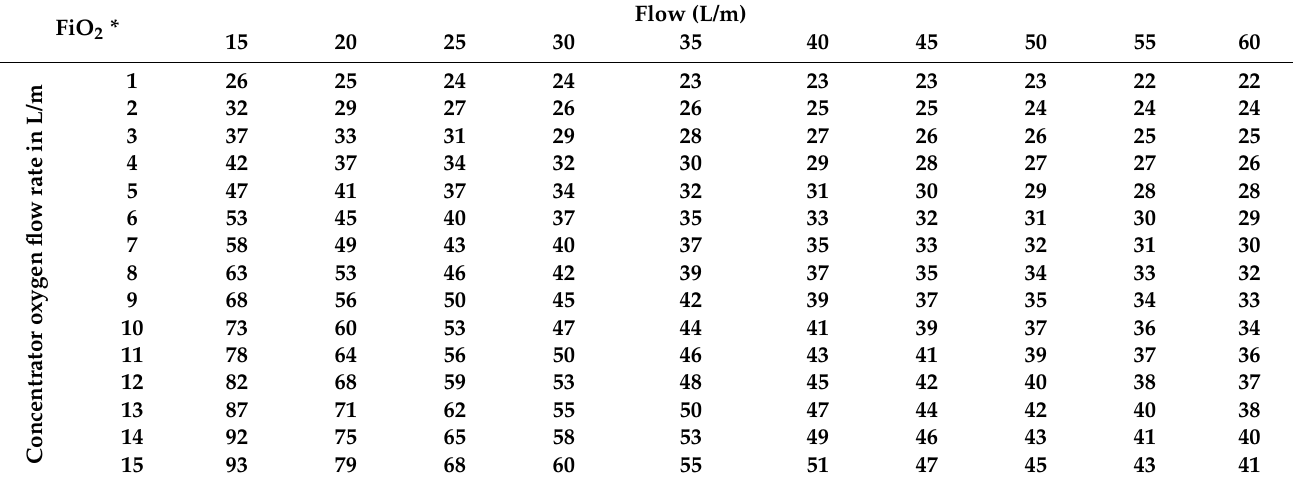
Table 2. Estimated FiO 2 according to domiciliary flow